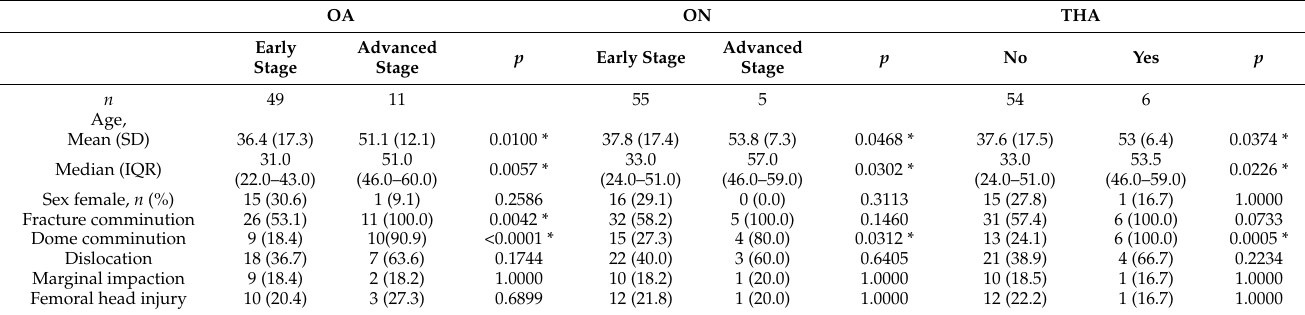
Table 3. The prognostic factors related to radiographic outcomes (OA, ON and THA). ON